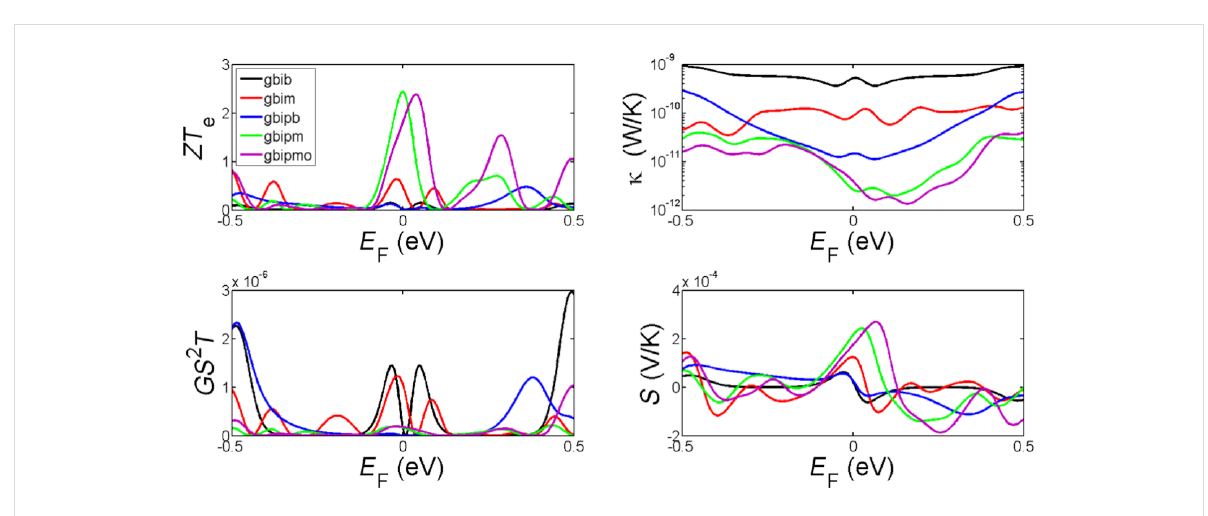
Figure 6: The variation of room-temperature values of ZT e , GS 2 T, S and κ as a function of E F for zigzag bilayer graphene nanoribbon (gbib), bilayer graphene with monolayer lead (gbim), engineered bilayer graphene nanopore (gbipb), engineered bilayer graphene nanopore with monolayer lead and hydrogen termination in pore side (gbipm), engineered bilayer graphene nanopore with monolayer lead and oxygen termination in pore side (gbipmo).